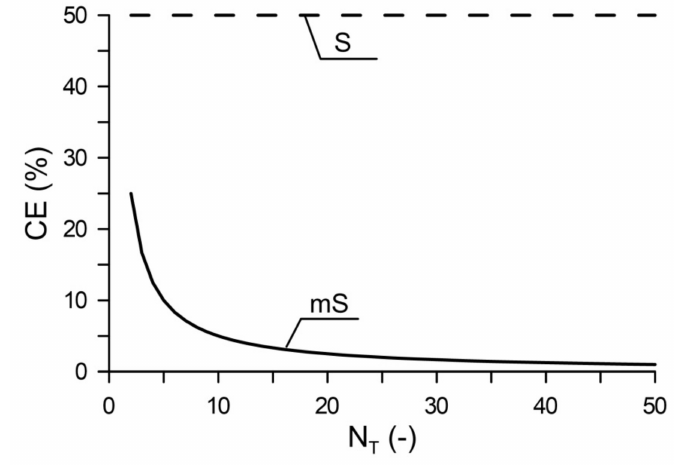
Figure 3. Increase of computational e ff ort ( CE ) with respect to the number of time steps ( N T ) for the standard Strang (S) and the modified Strang (mS)